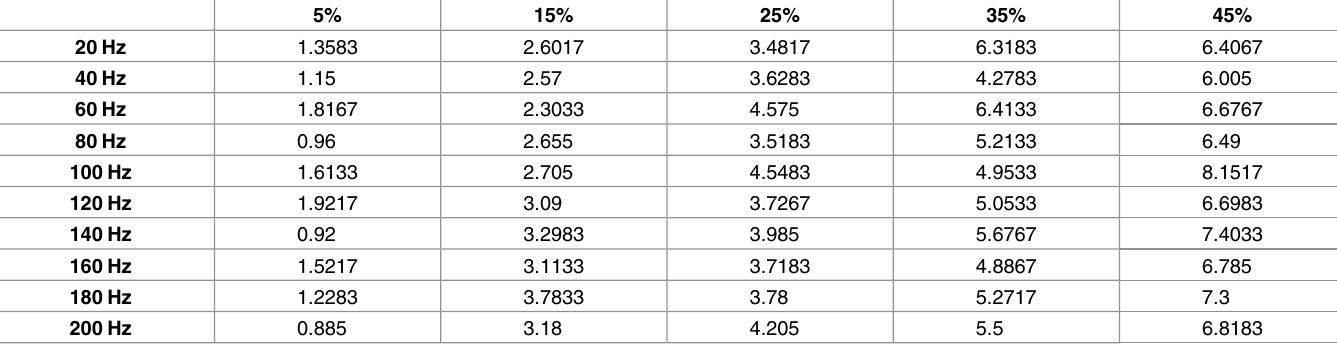
Table 1. Percentage (%) of data points where the prediction method error was greater than 0.01%, for varying PWM frequency (Hz) and percent voltage and current sensor